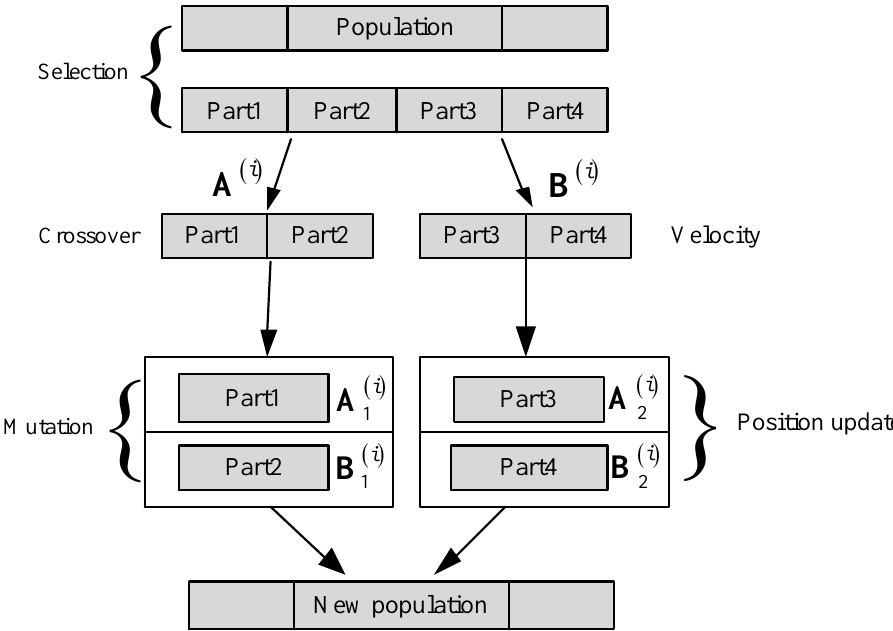
Figure 4. The flow of the